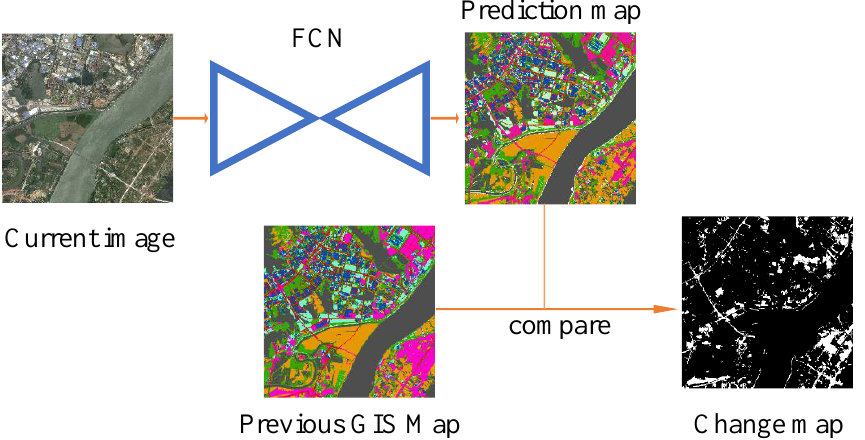
Figure 2. The structure for change detection. The FACNN is used to extract a segmentation map from the new image. The segmentation map is compared to the GIS map 2014 to produce a pixelwise change map.